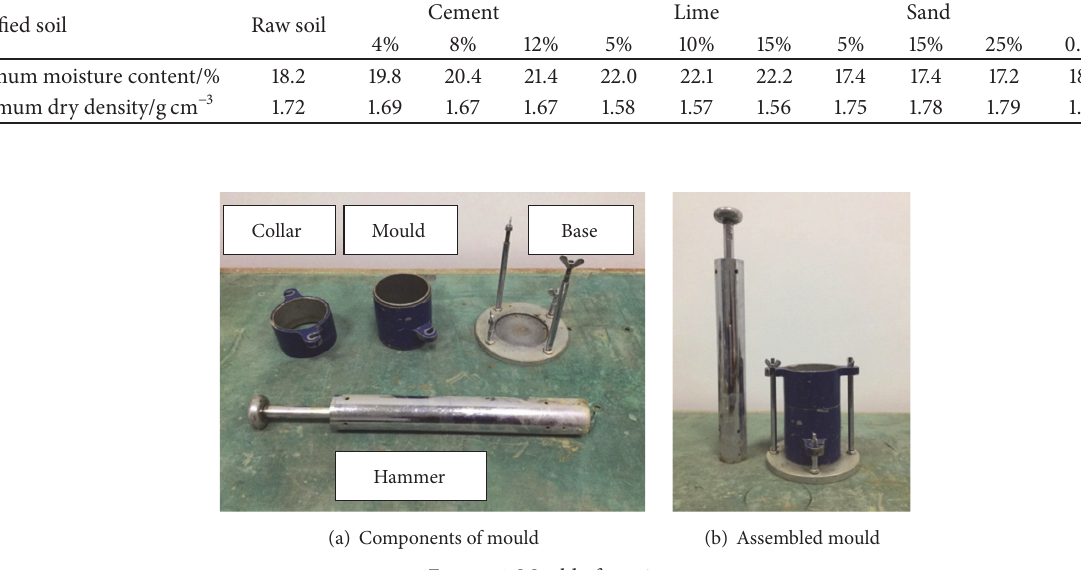
Figure 1: Mould of specimens.